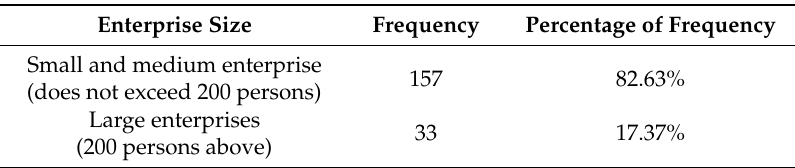
Table 1. Enterprise size.